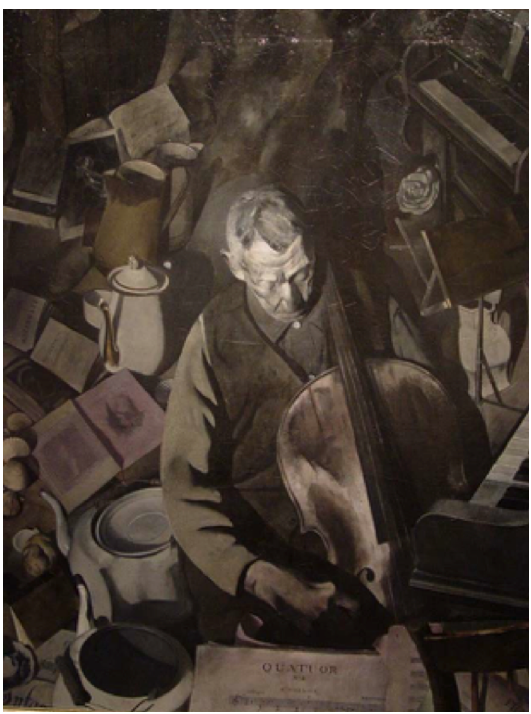
Figure 1 | Edwin Dickinson The Cello Player